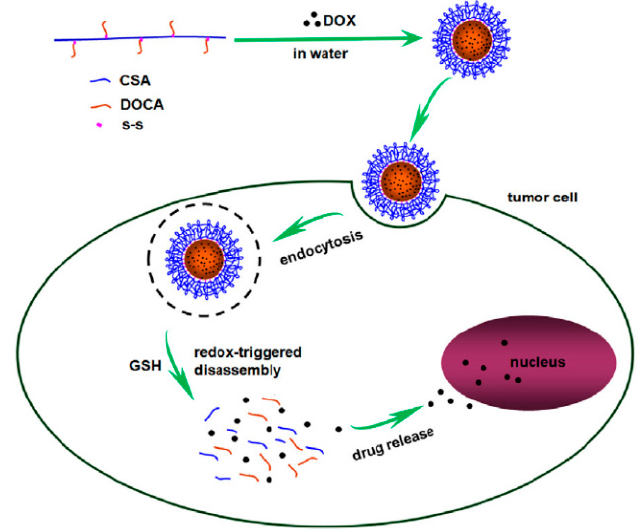
Figure 10. Illustration of the preparation of micelle doxorubicin (DOX)-loaded chondroitin sulfate A (CSA)-disulfide bond (ss)-deoxycholic acid (DOCA) (CSA-ss-DOCA/DOX) and the mechanism of action in a tumor cell. Modified from [110].